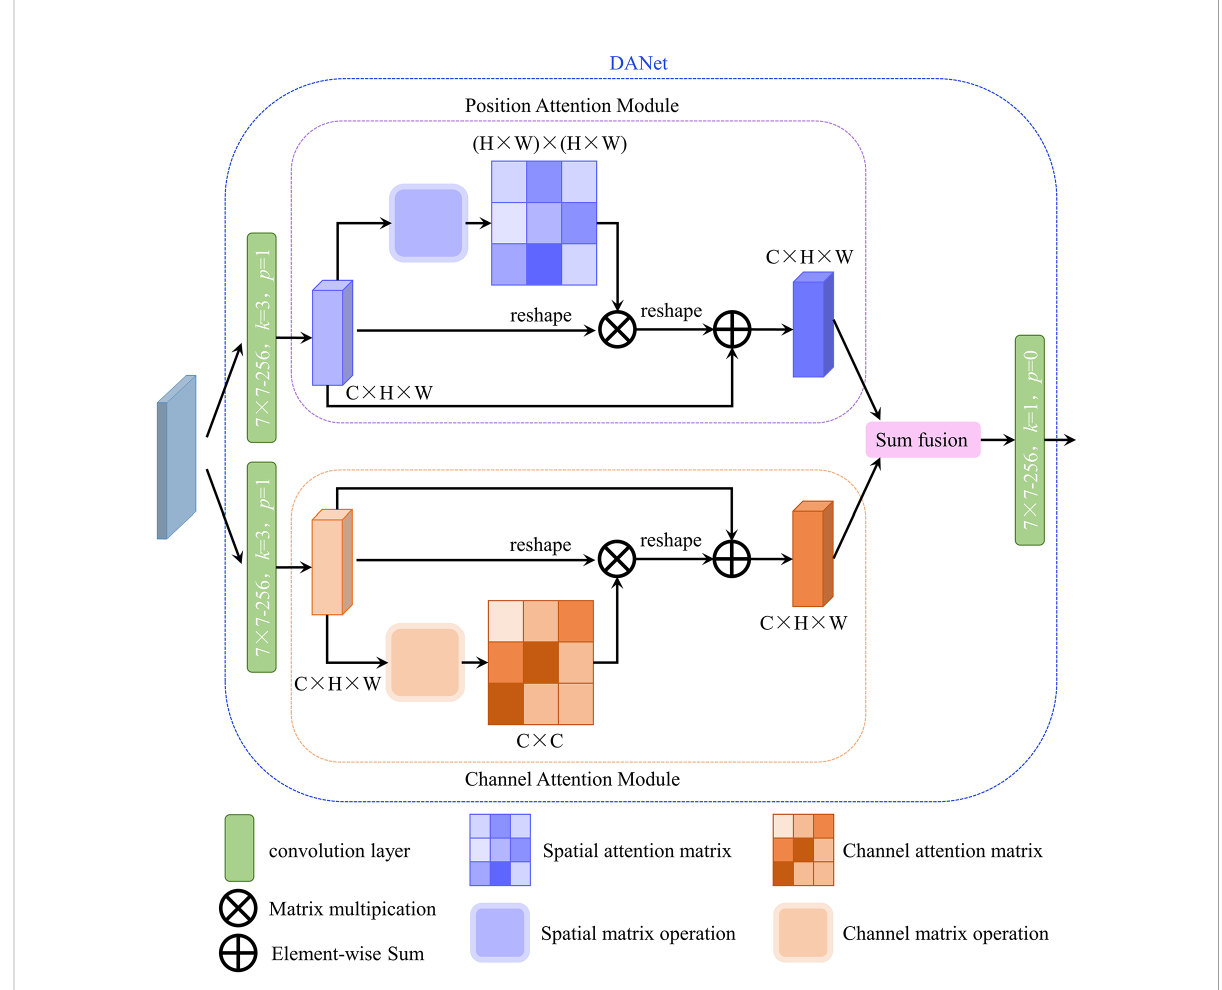
FIGURE 3 Structure of DANet. ( H , W and C are the height, width and channel of the input feature map,